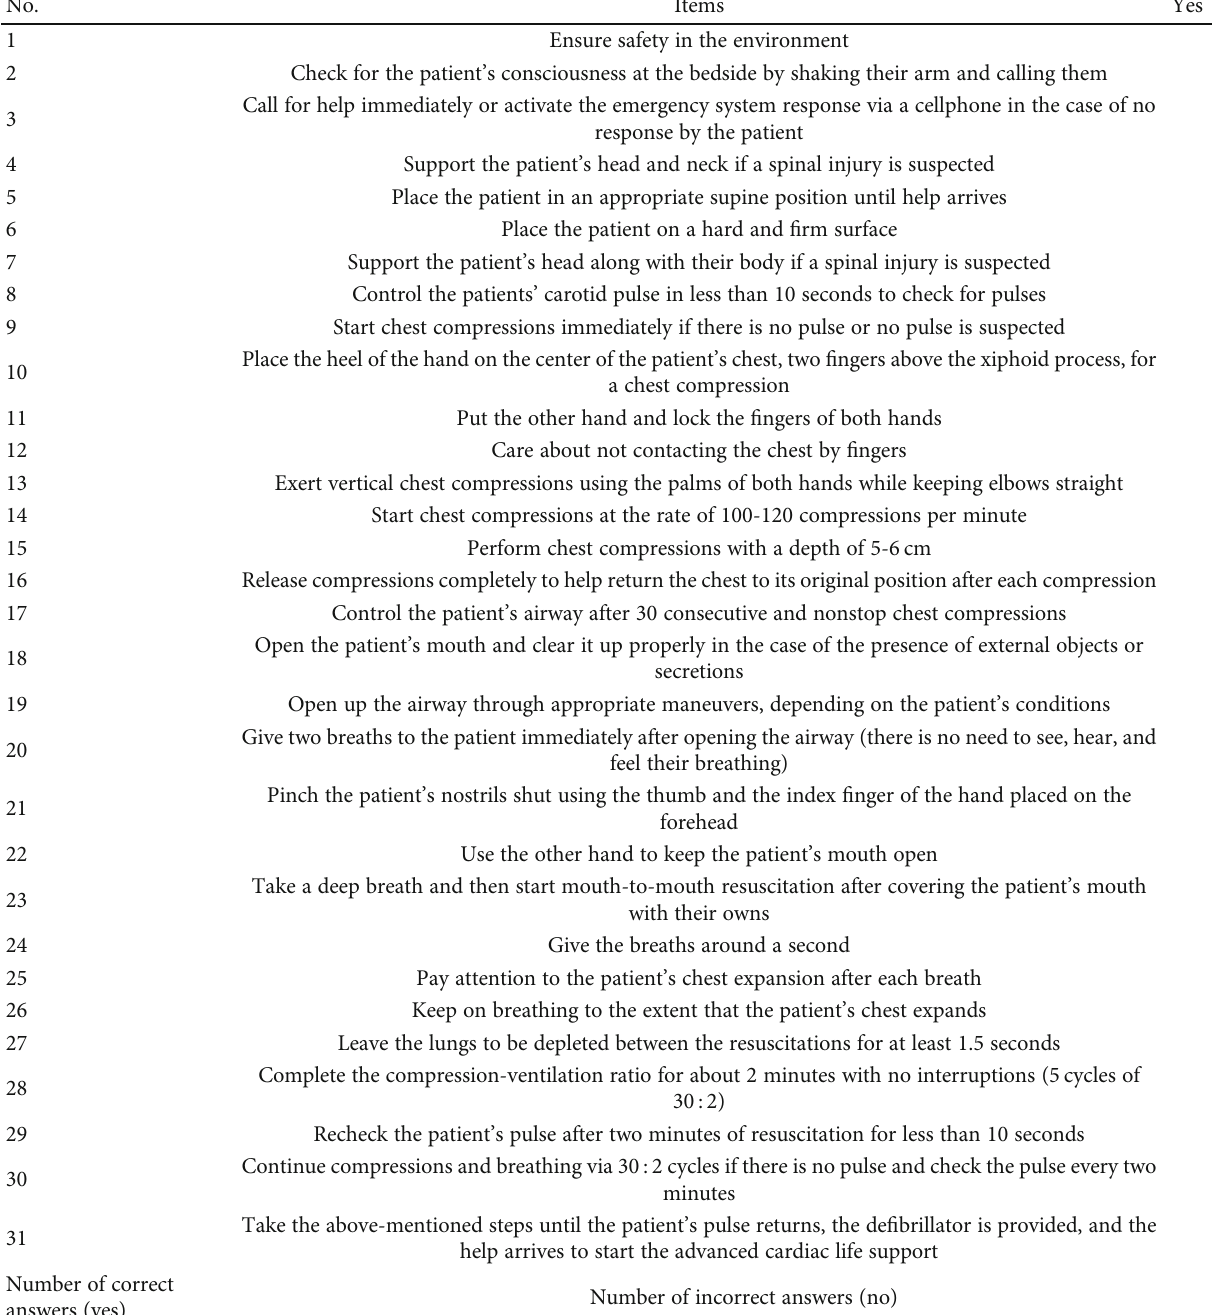
Table 4: The checklist for basic life support (BLS) performance evaluation in adults according to 2015 American Heart Association (AHA) guidelines for cardiopulmonary resuscitation